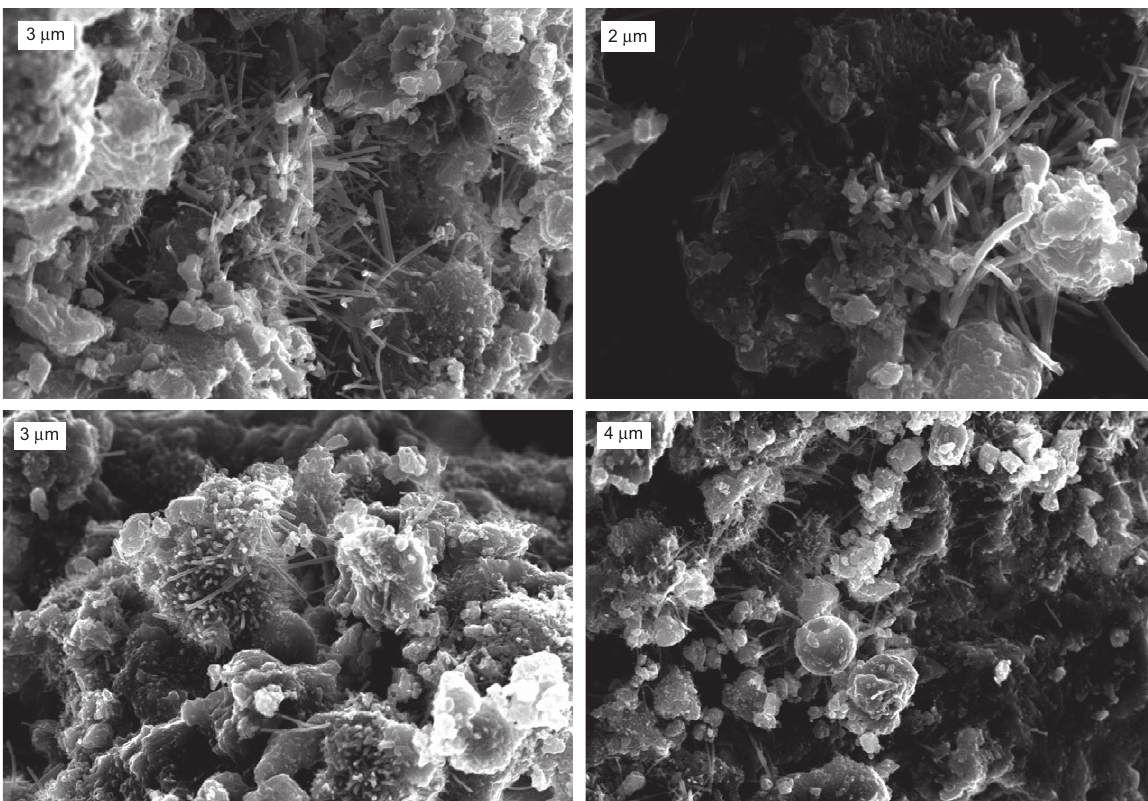
Figure 8 SEM photographs after 56-day